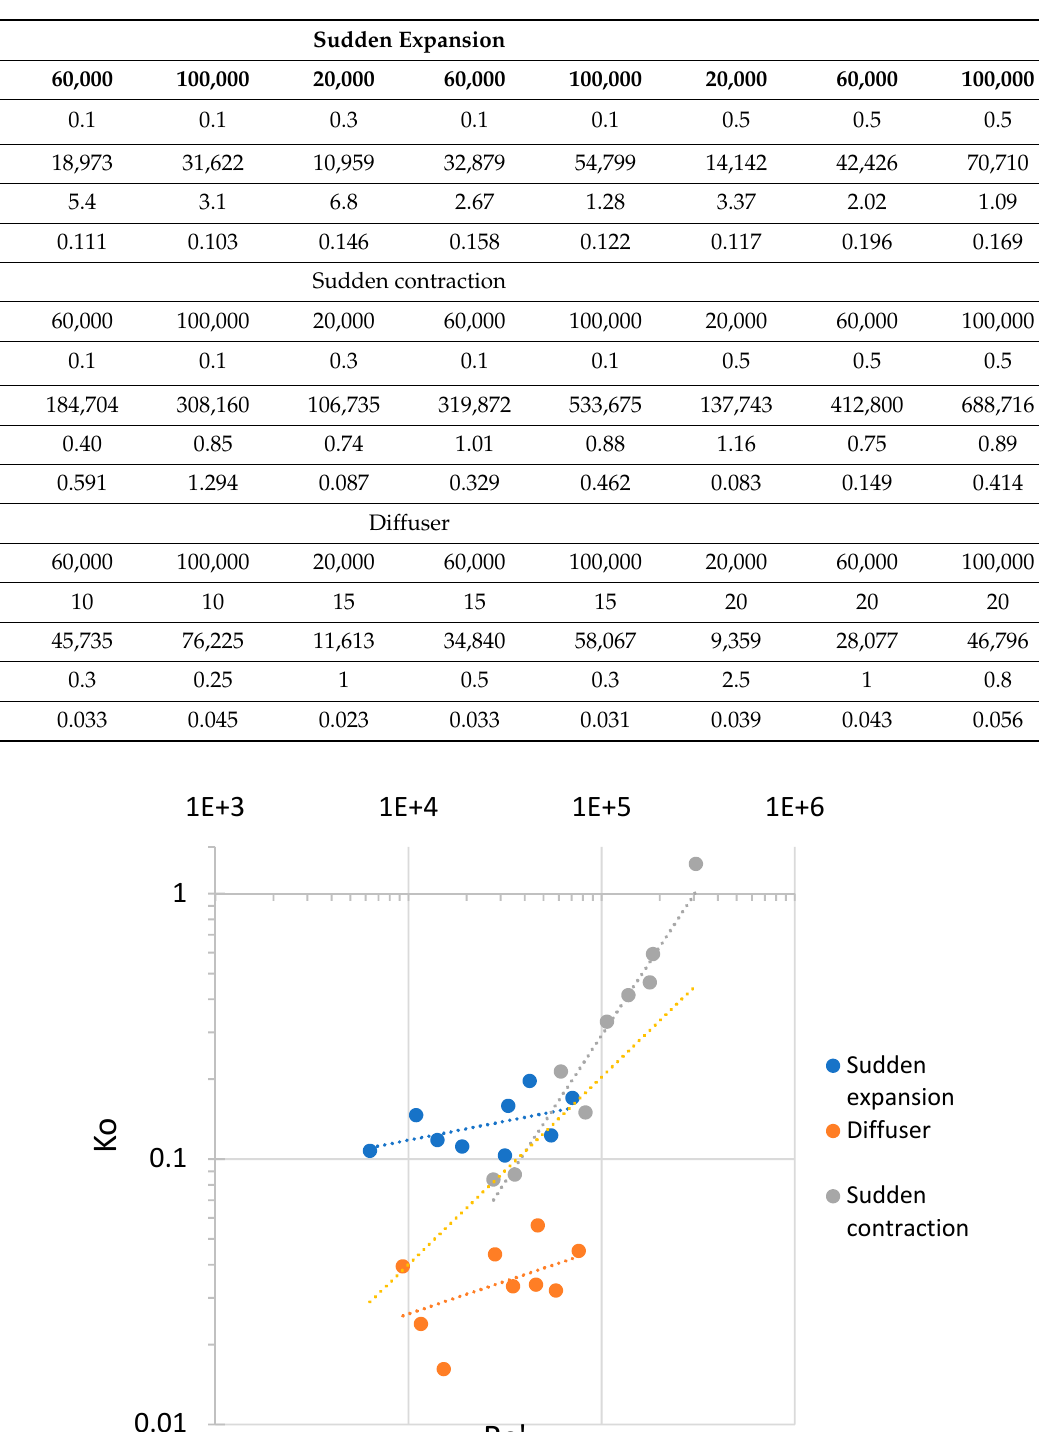
Table 4. Grid convergence data for the considered single channels.